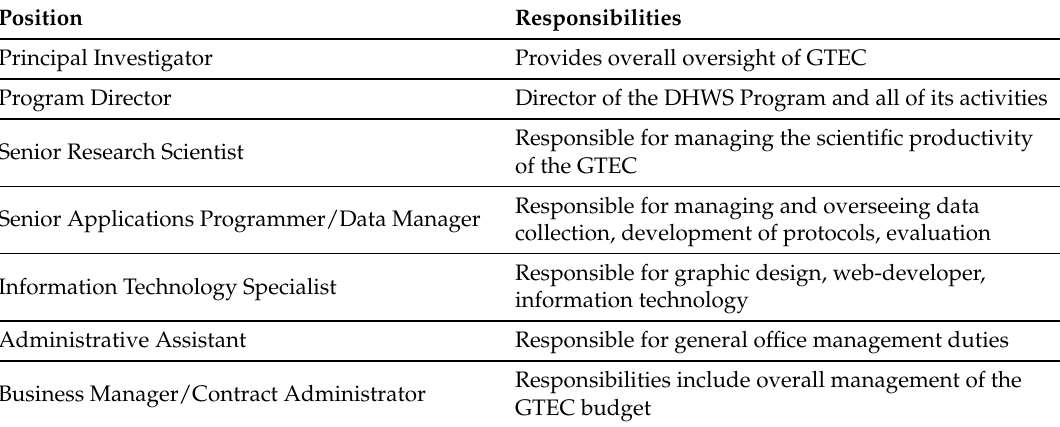
Table 1. Structure of the Jackson Heart Study Graduate Training and Education Center.